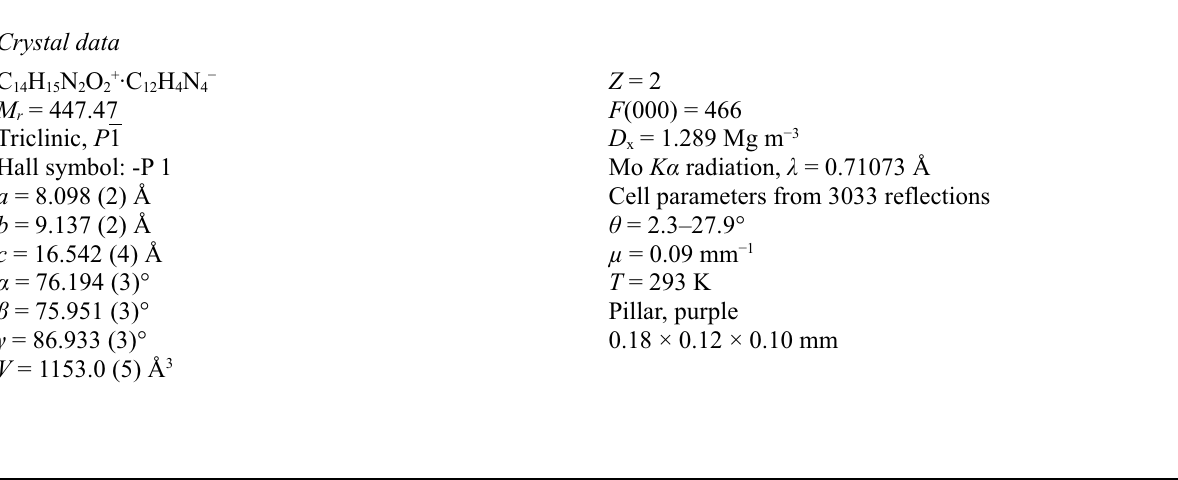
A side-view of the one-dimensional anionic stack of (I). 3,5-dimethyl-1-(4-nitrobenzyl)pyridinium